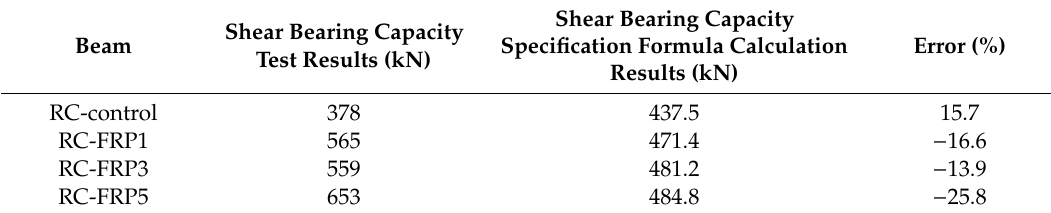
Table 10. Experimental and standard calculation results for the shear capacity of RC beams.